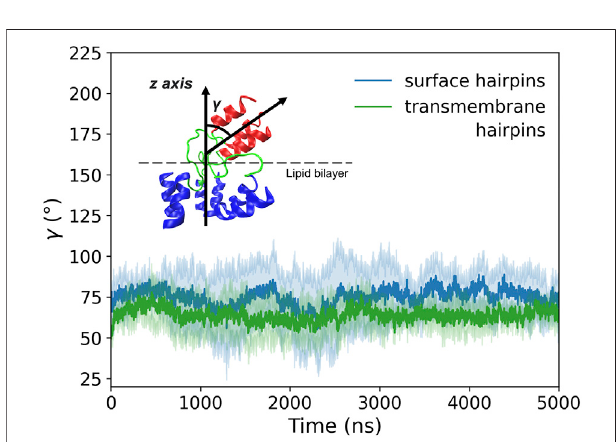
FIGURE 9 | Tilt angle ( γ ) of membrane-bound HA2 N-terminus de fi ned as an angle between the coiled-coil axis and the z -axis perpendicular to the membrane plane. Shadows correspond to one standard